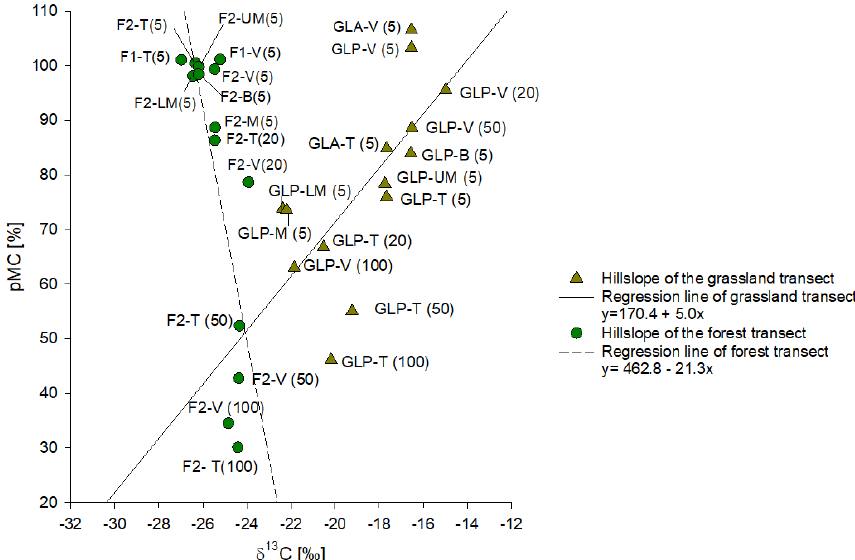
Figure 5. Comparison of the average value of 14 C pMC of bulk SOC plotted against δ 13 C of SOC of grassland and forested soil. Each point is labelled by the transect position and the top depth interval. Continuous and dotted black lines represent the regression lines for grassland soil data and forest soil data,